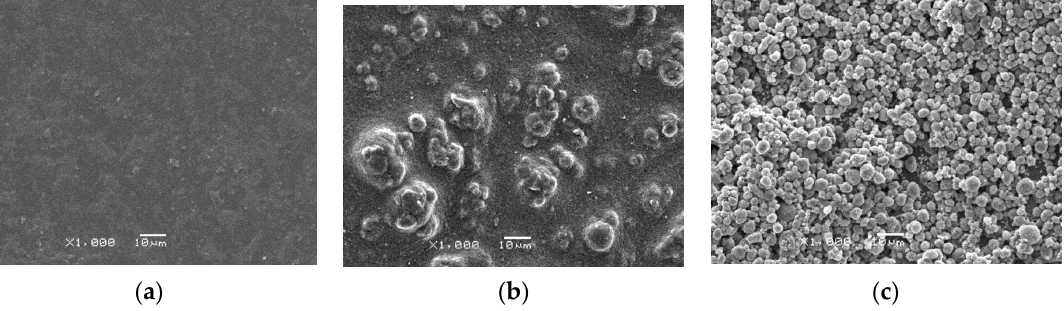
Figure 5. SEM images. ( a ) general Nafion membrane. ( b ) PVDF–Nafion composite membrane. ( c ) modified PVDF–Nafion composite membrane.